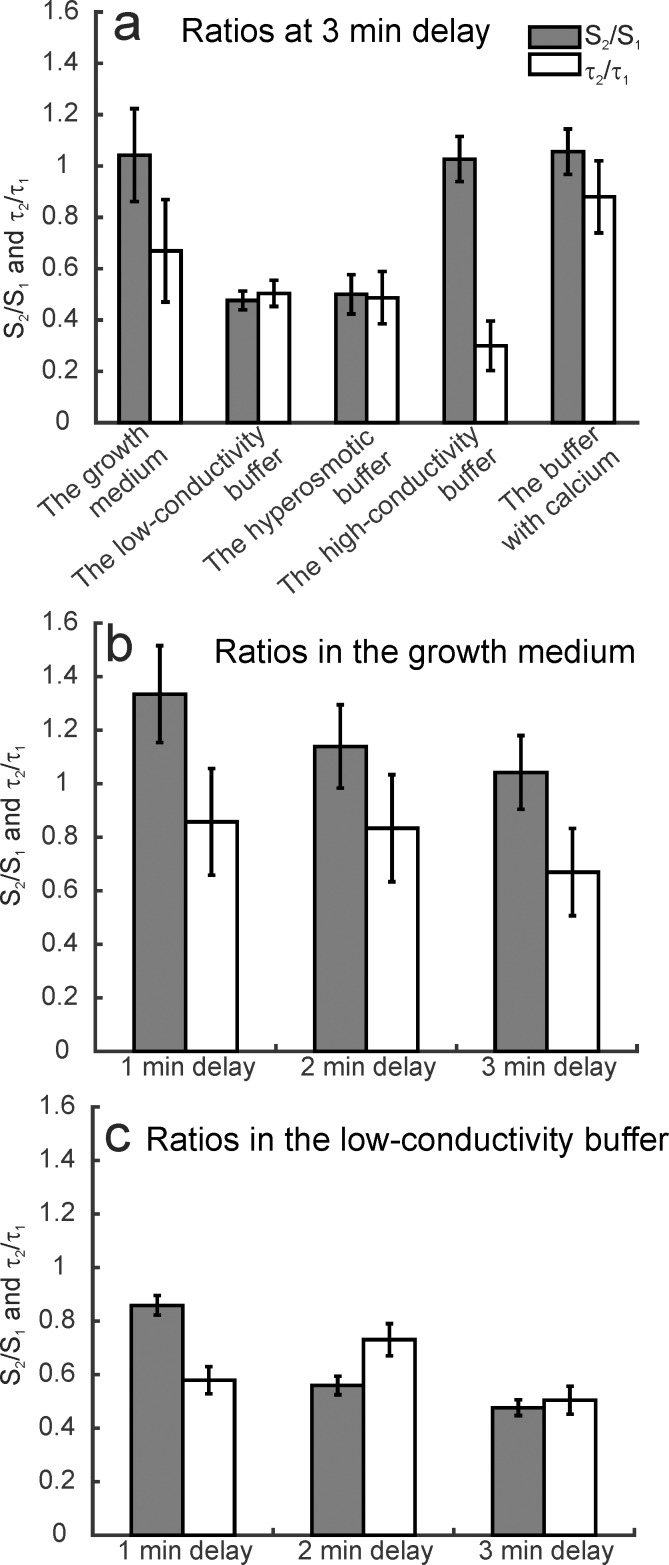
Graphical representation of the ratio of parameters S2/S1 and τ2/τ1.A first order model (Eqs 1 and 2) was fitted to the experimental results. S2 and τ2 were normalized to the average value of S1 or τ1, calculated from parameters of the half dose and the split doses with different delays. (a) The ratios at 3 minute delay between the trains in all buffers. (b) The ratios in the growth medium at 1, 2 or 3 minute delay. (c) The ratios in the low-conductivity buffer at 1, 2 and 3 minute delay. The bars at 3 minute delay in (b) and (c) represent the same results as the growth medium and the low-conductivity buffer bars in (c) to enable easier comparison of the ratios between the buffers. Error bars represent the 95% confidence interval.